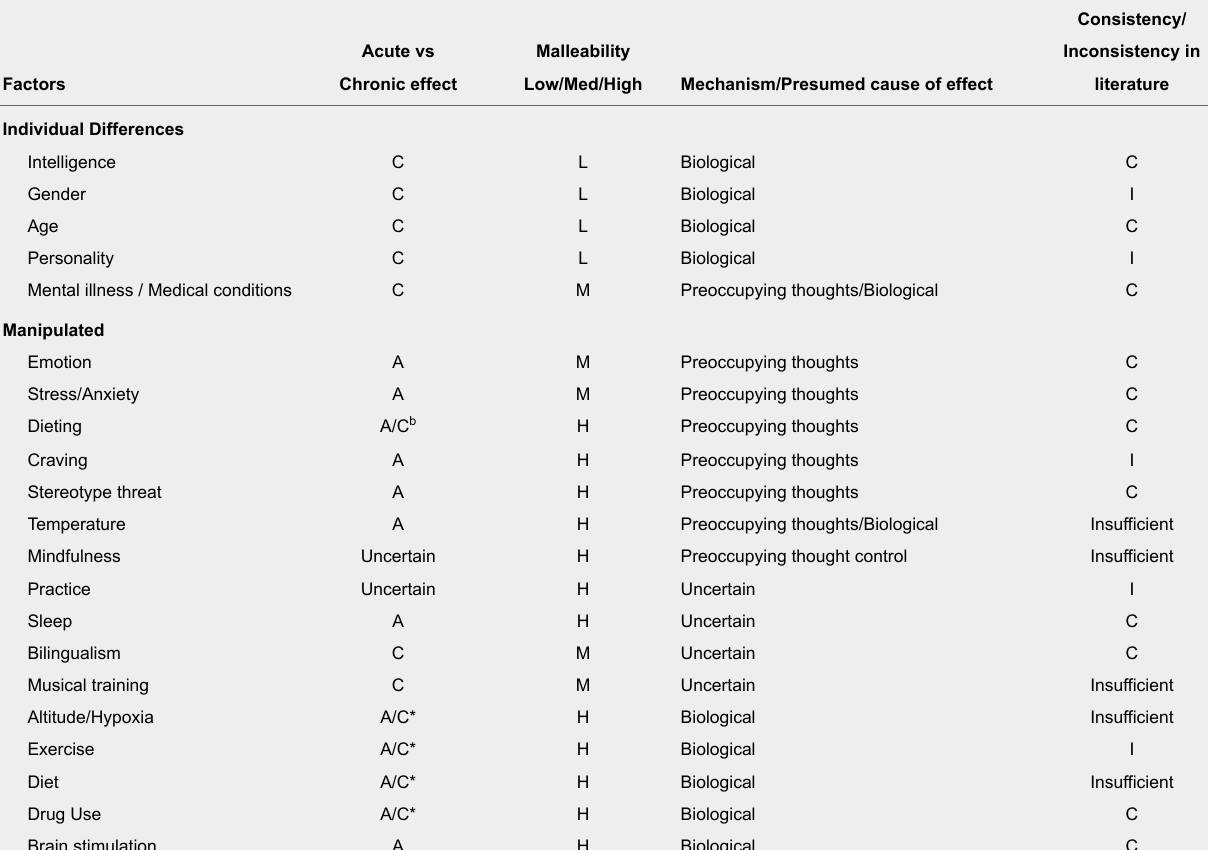
A Summary of Factors That Influence